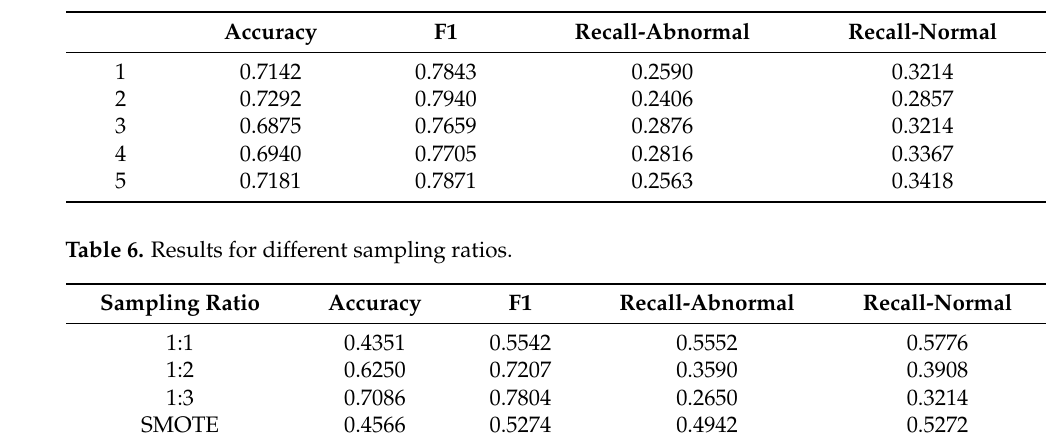
Table 5. Results for sampling ratios = 1:3 with k = 5.